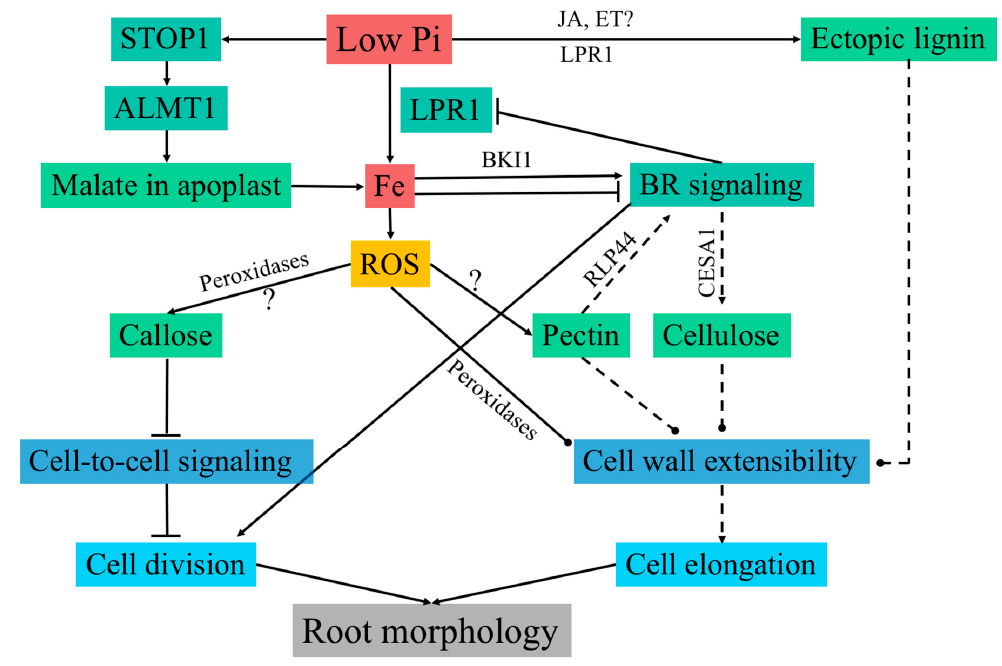
Figure 2. Model of cell wall regulation in response to Pi starvation. Low Pi causes LPR1-dependent Fe accumulation in the apoplast, which is required for the inhibition of primary root growth. Low Pi also leads to activation of the transcription factor STOP1 through an unknown mechanism. STOP1 induces the malate transporter ALMT1 by directly binding to its promoter. Subsequently, ALMT1